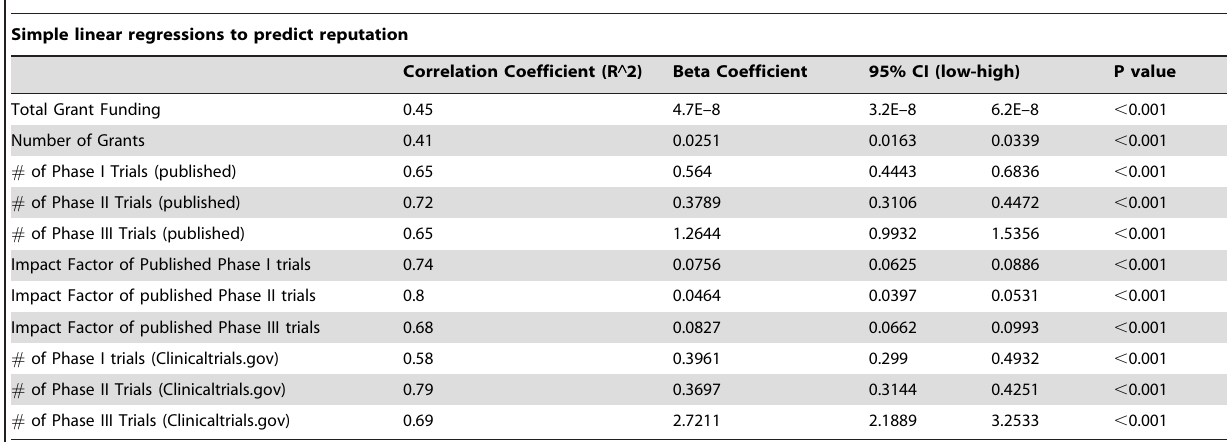
Table 4. Correlation coefficients (R2) between US News and World Report Reputation Score, and measures of research productivity.